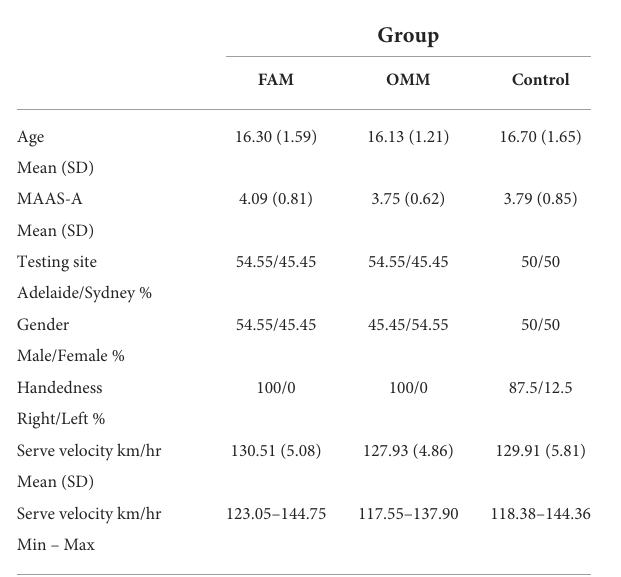
TABLE 3 Age, trait mindfulness, testing site, gender, handedness, and serve velocity in the meditation and control groups.